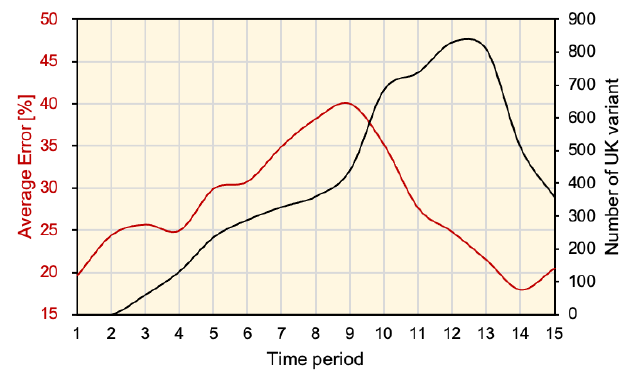
Figure 7. Average relative error in DPC estimation using deep learning in different time periods and the number of new UK viral variants reported in regions of the study.